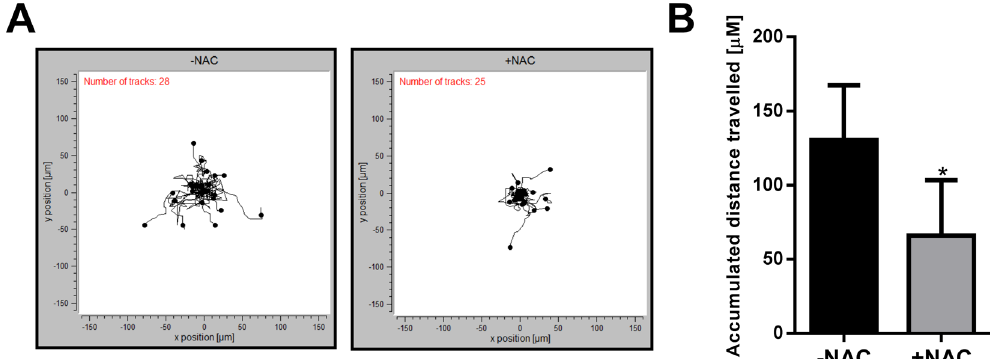
Figure 6. ROS scavenging with NAC reduces cell migration under hypoxic conditions. MDA-MB-468 cells were treated with NAC and exposed to hypoxia. Cell migration was analysed from 24 h to 36 h under hypoxic conditions. ( A ) Spatial plot of all cells from representative wells from the same experiment and ( B ) quantitative analysis of the mean accumulated distance travelled by cells from three independent experiment (duplicate wells) treated with NAC compared to the control cells without NAC treatment. * p < 0.05, (paired